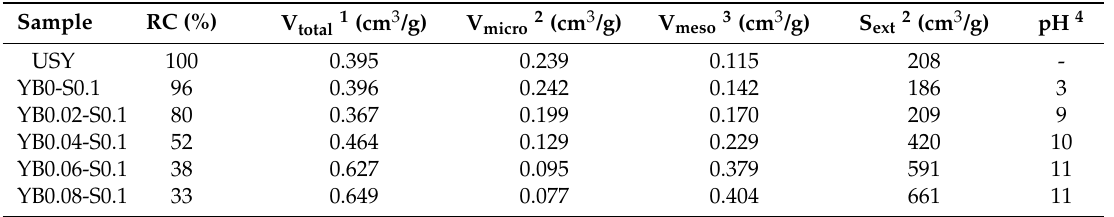
Table 3. Relative crystallinity and textural properties of the modified zeolites, according to the base concentration used.